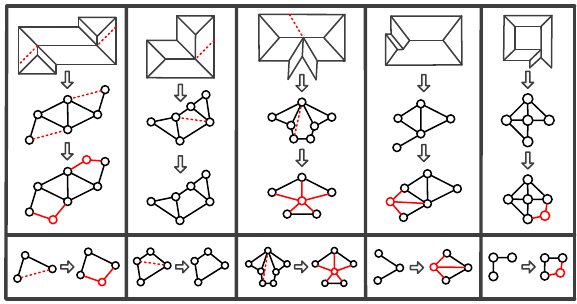
Figure 5. An example of graph edit dictionary. Top: typical errors and correction methods. Bottom: entries in the graph edit dictionary. The red dashed lines are false intersection lines in the building model and false edges in the top-graph. The red circles and lines represent new generated nodes and edges.